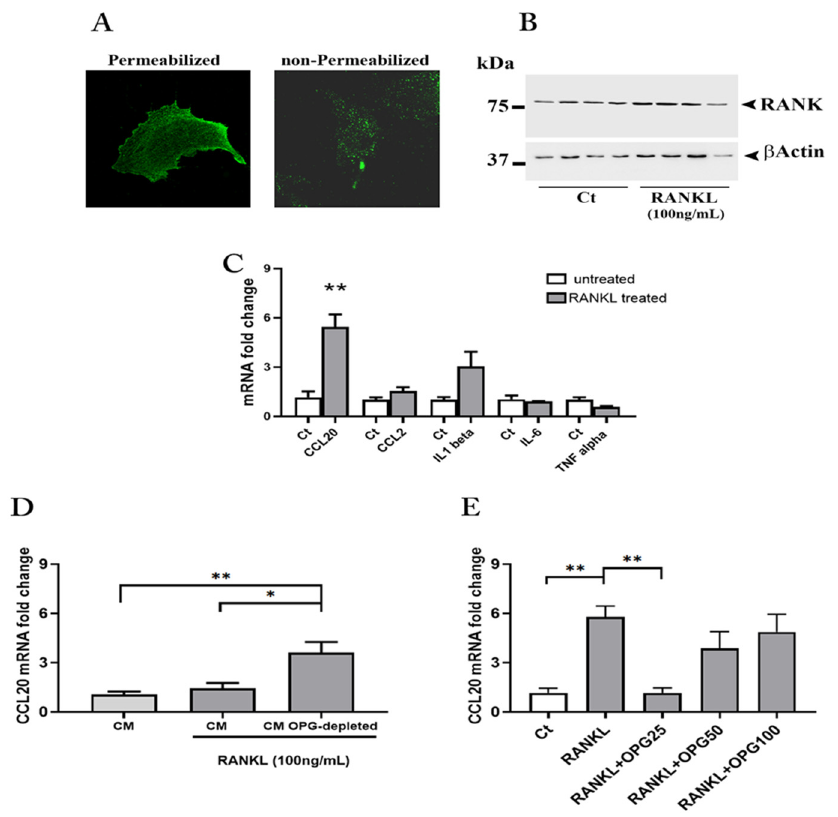
Figure 4. RANK-RANKL-OPG in human astrocytes. Representative immunofluorescence staining for RANK in astrocytes ( A ). RANK protein expression in astrocytes after the treatment with rh RANKL (original magnification 63X) ( B ). mRNA quantification for cytokines and chemokines in rh RANKL treated astrocytes ( C ). mRNA quantification for CCL20 in astrocytes treated with rh RANKL plus Conditioned Media (CM) from term placenta explants or CM OPG-depleted ( D ). mRNA quantification for CCL20 in astrocytes treated with rh RANKL or RANKL plus rh OPG (25, 50 and 100 ng/mL) ( E ). Data expressed as mean ± SEM of four separate experiments performed in quadruplicate. Significance was determined with Mann–Whitney test for data in ( C ) and one-way ANOVA for data in ( D ) and ( E ). * p < 0.05; ** p < 0.01.